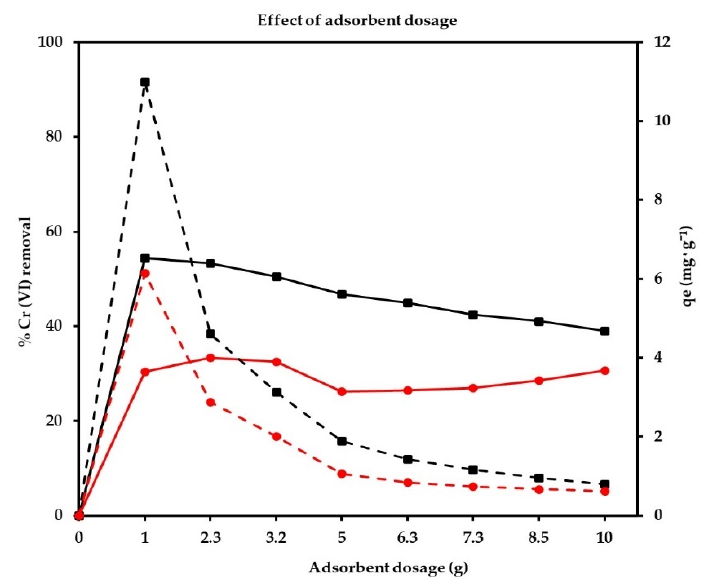
Figure 3. Effect of adsorbent dose on equilibrium adsorption capacity and removal efficiency (C 0 = 200 mg/L, temperature = 25 °C, and pH = 3). The red lines (solid and dotted) represent the removal of Cr (VI) with JST and the adsorption capacity in the tests where this material was used. The black lines (solid and dotted) represent the removal of Cr (VI) with JTT and the adsorption capacity in the tests where this material was used.